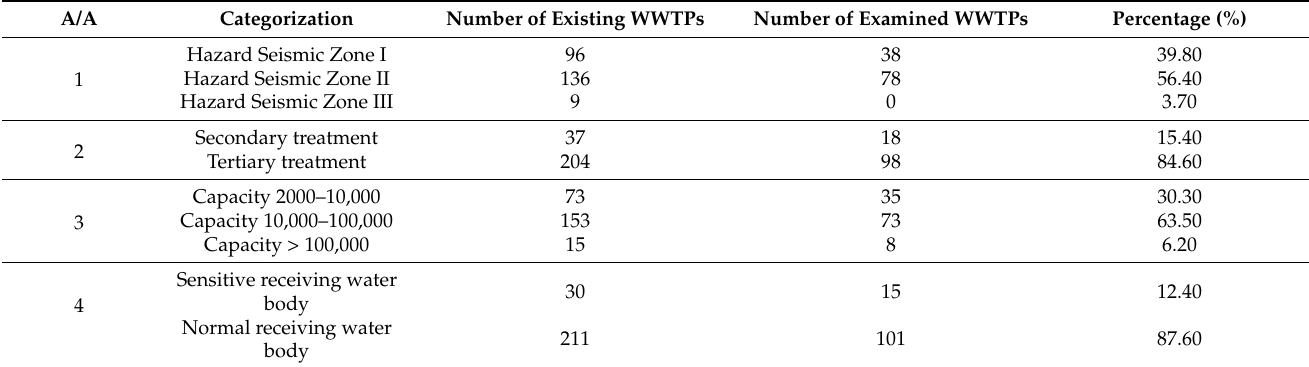
Table 2. Percentage of the WWTPs, according to EHZ, treatment, capacity and receiving water body ( n = 241).